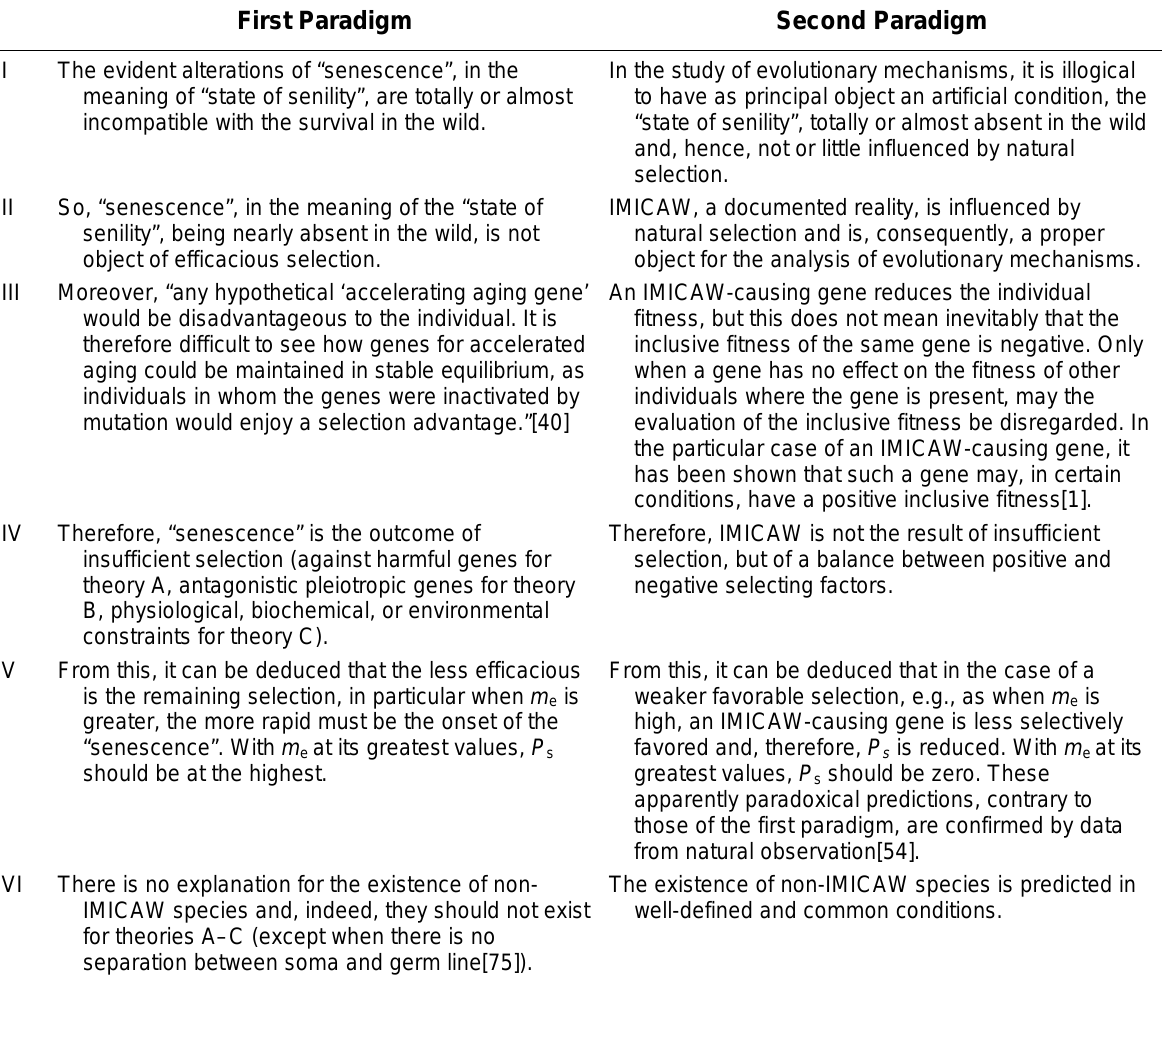
Differences Between the Two Paradigms First Paradigm Second